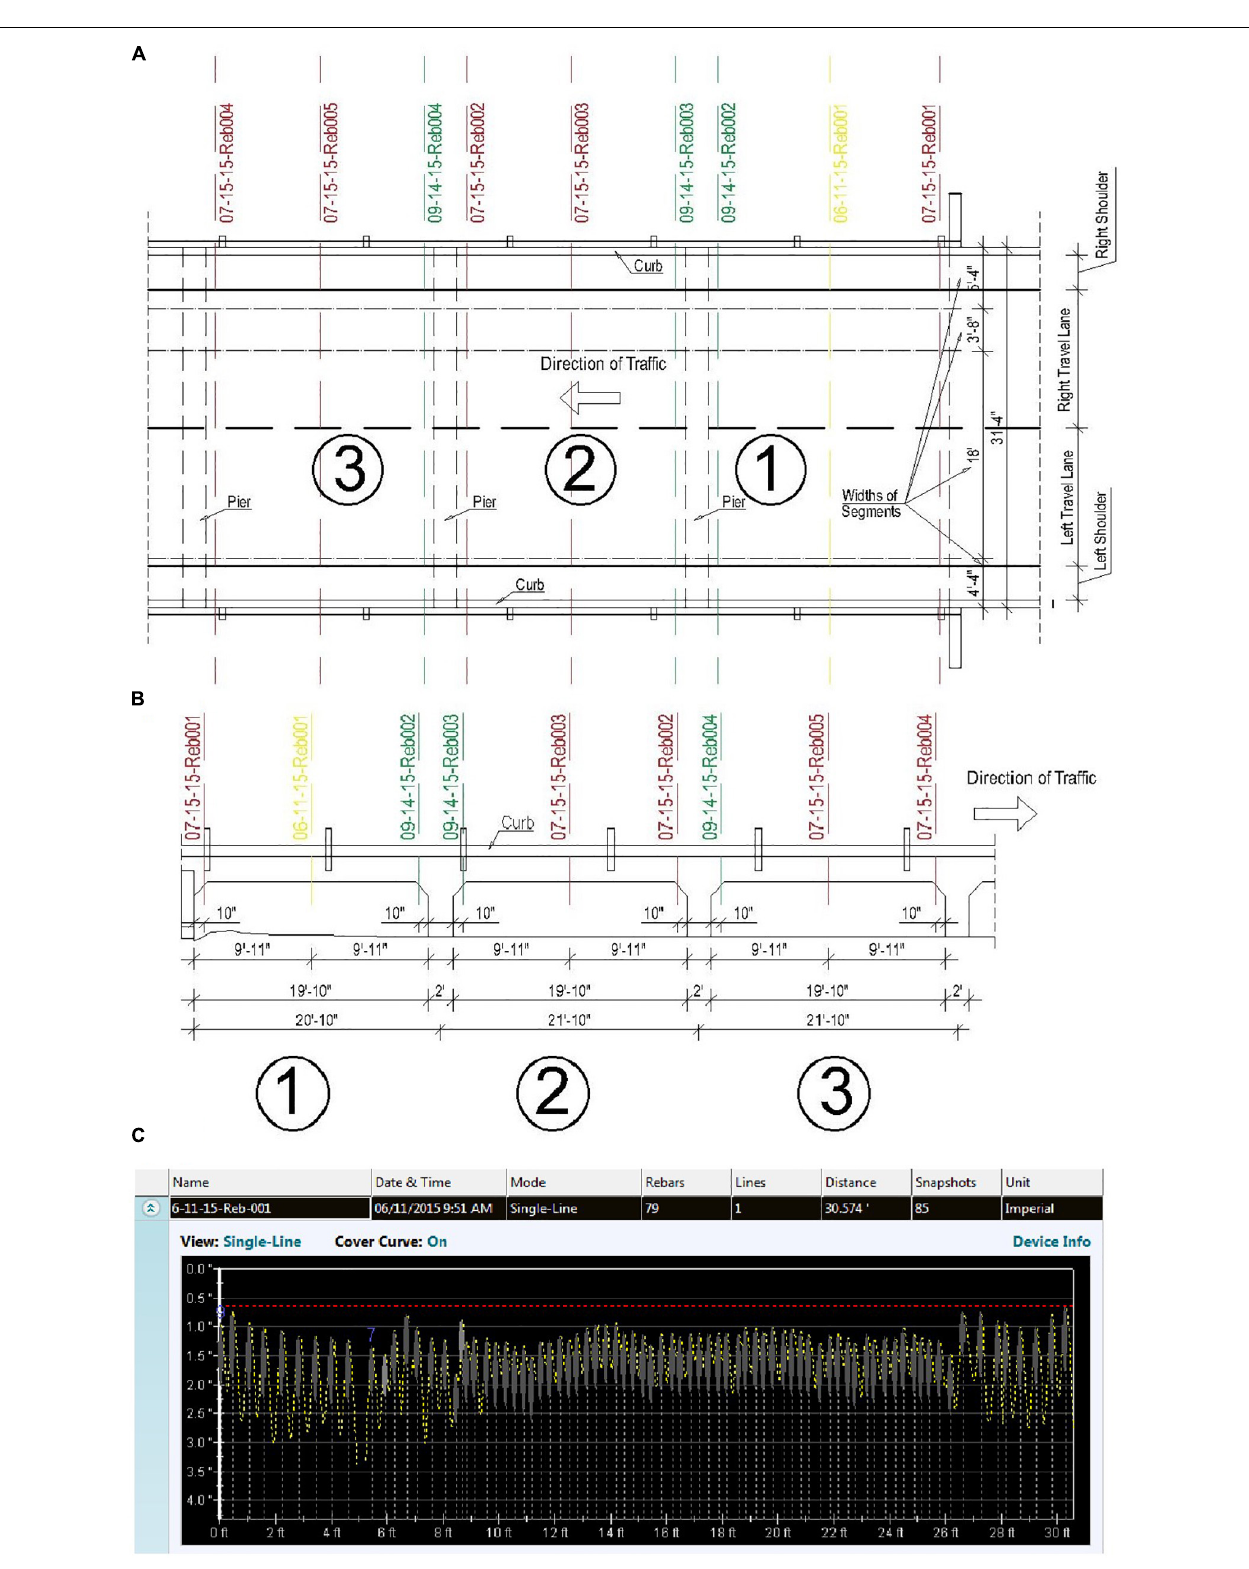
FIGURE 3 | (A) Location of the reinforcement measurements – plan view, (B) location of the reinforcement measurements – NE elevation, (C) line measurement of reinforcing bars – scan 06-11-15-Reb001 (1 ft = 0.305 m, 1 inch = 25.4 mm).